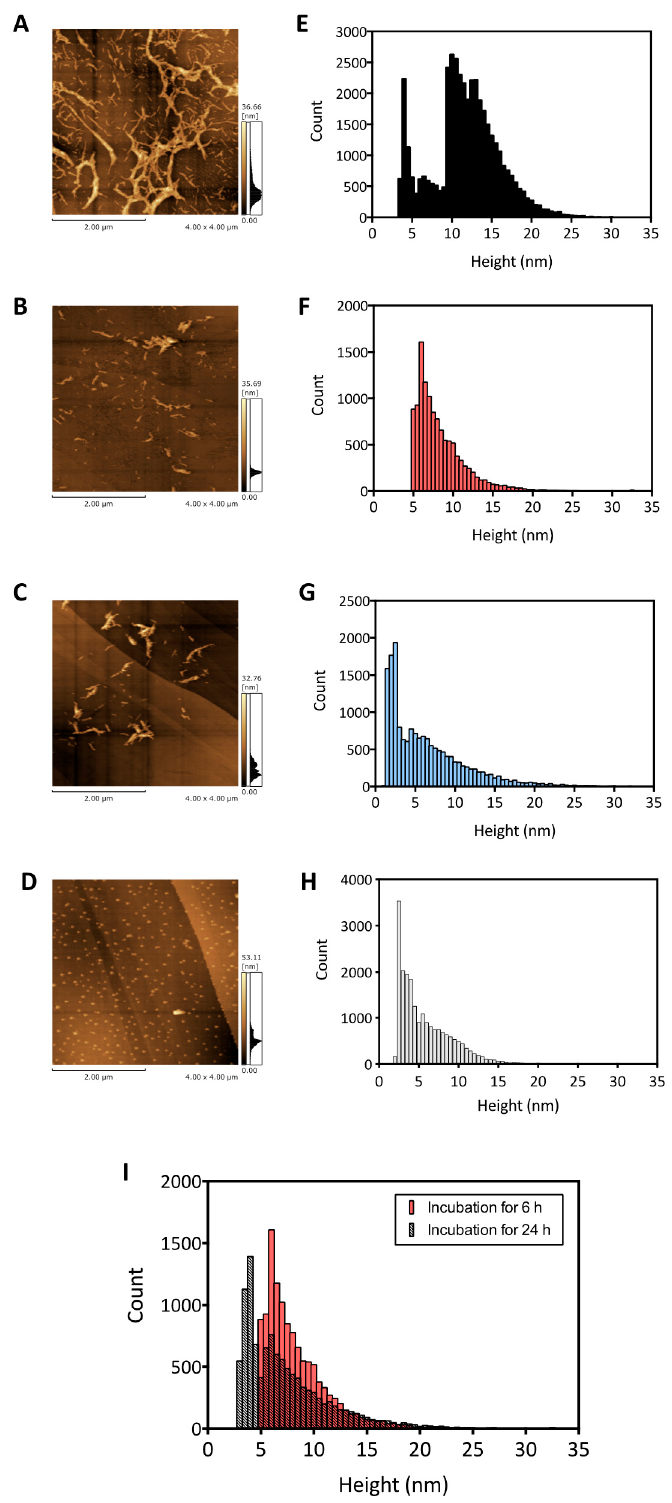
Figure 3. Representative atomic force microscopy images and histogram of the height distribution of untreated amyloid β (A β ) fibrils ( A,E ), A β fibrils incubated for 6 h with epigallocatechin gallate (EGCG) ( B,F ), A β fibrils incubated for 6 h with dopamine (DA) ( C,G ), and A β before fibrillization ( D,H ); A β fibrils mixed with EGCG or DA at a molar ratio of 1:0.56 ( I ); time dependence of height distribution of A β incubated in the presence of EGCG for 6 h (pink bar, same data as ( F )) and 24 h (black shaded bar).